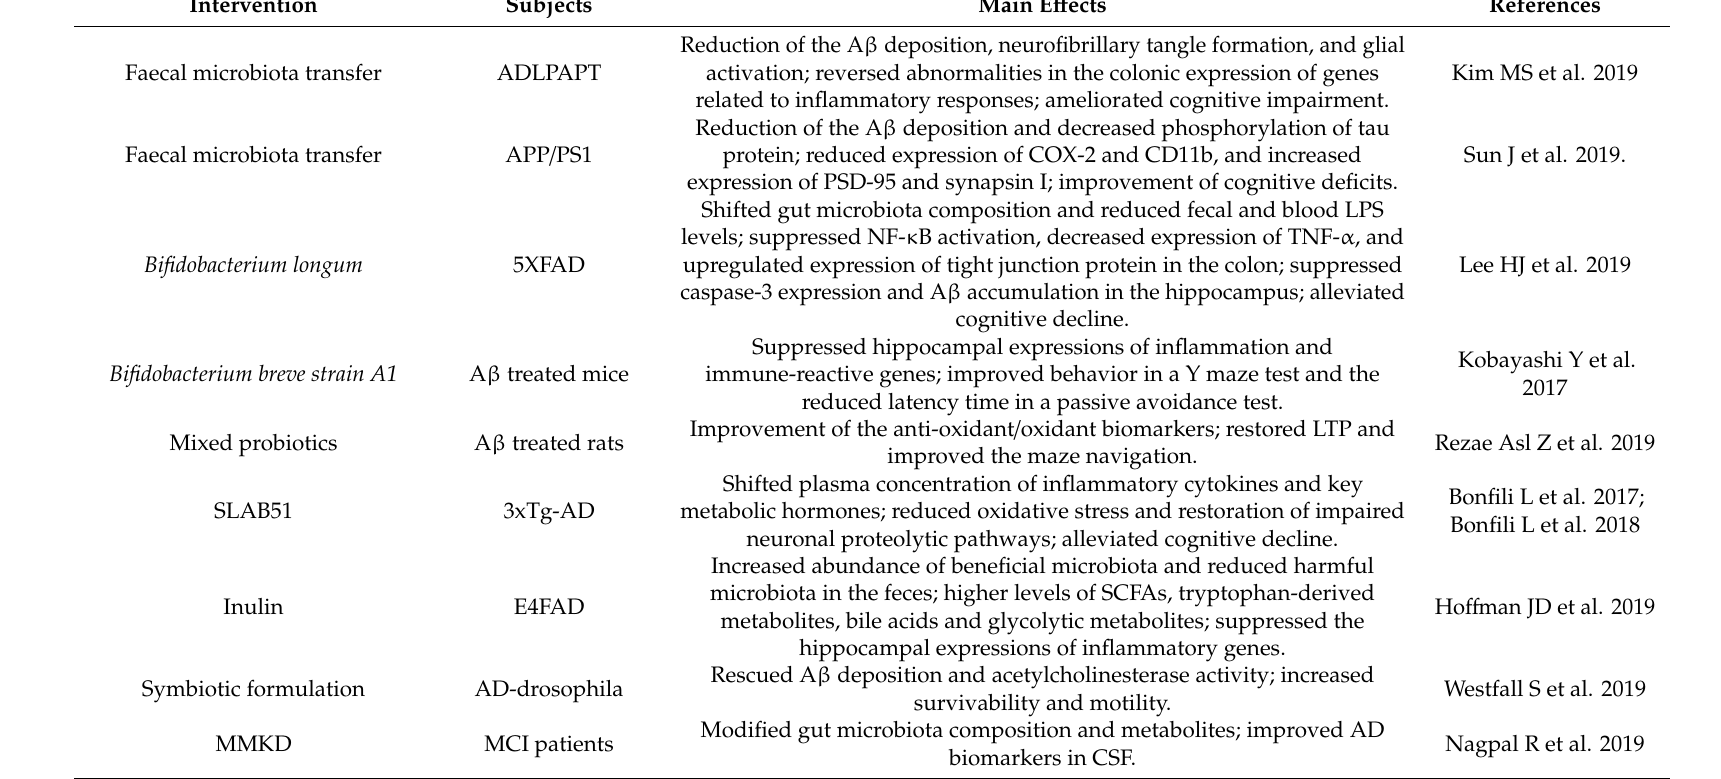
Table 3. Summary of studies to modify the gut microbiota in AD models and